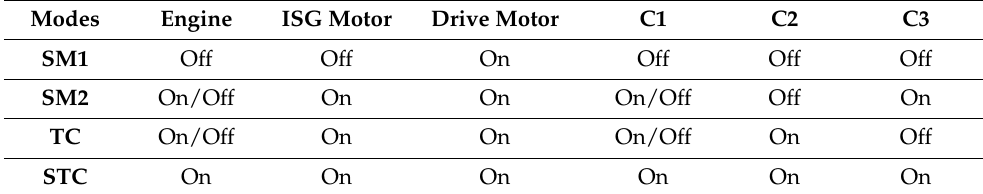
used in the parameter matching process that combined the tractor powertrains and driven resistance of the agricultural